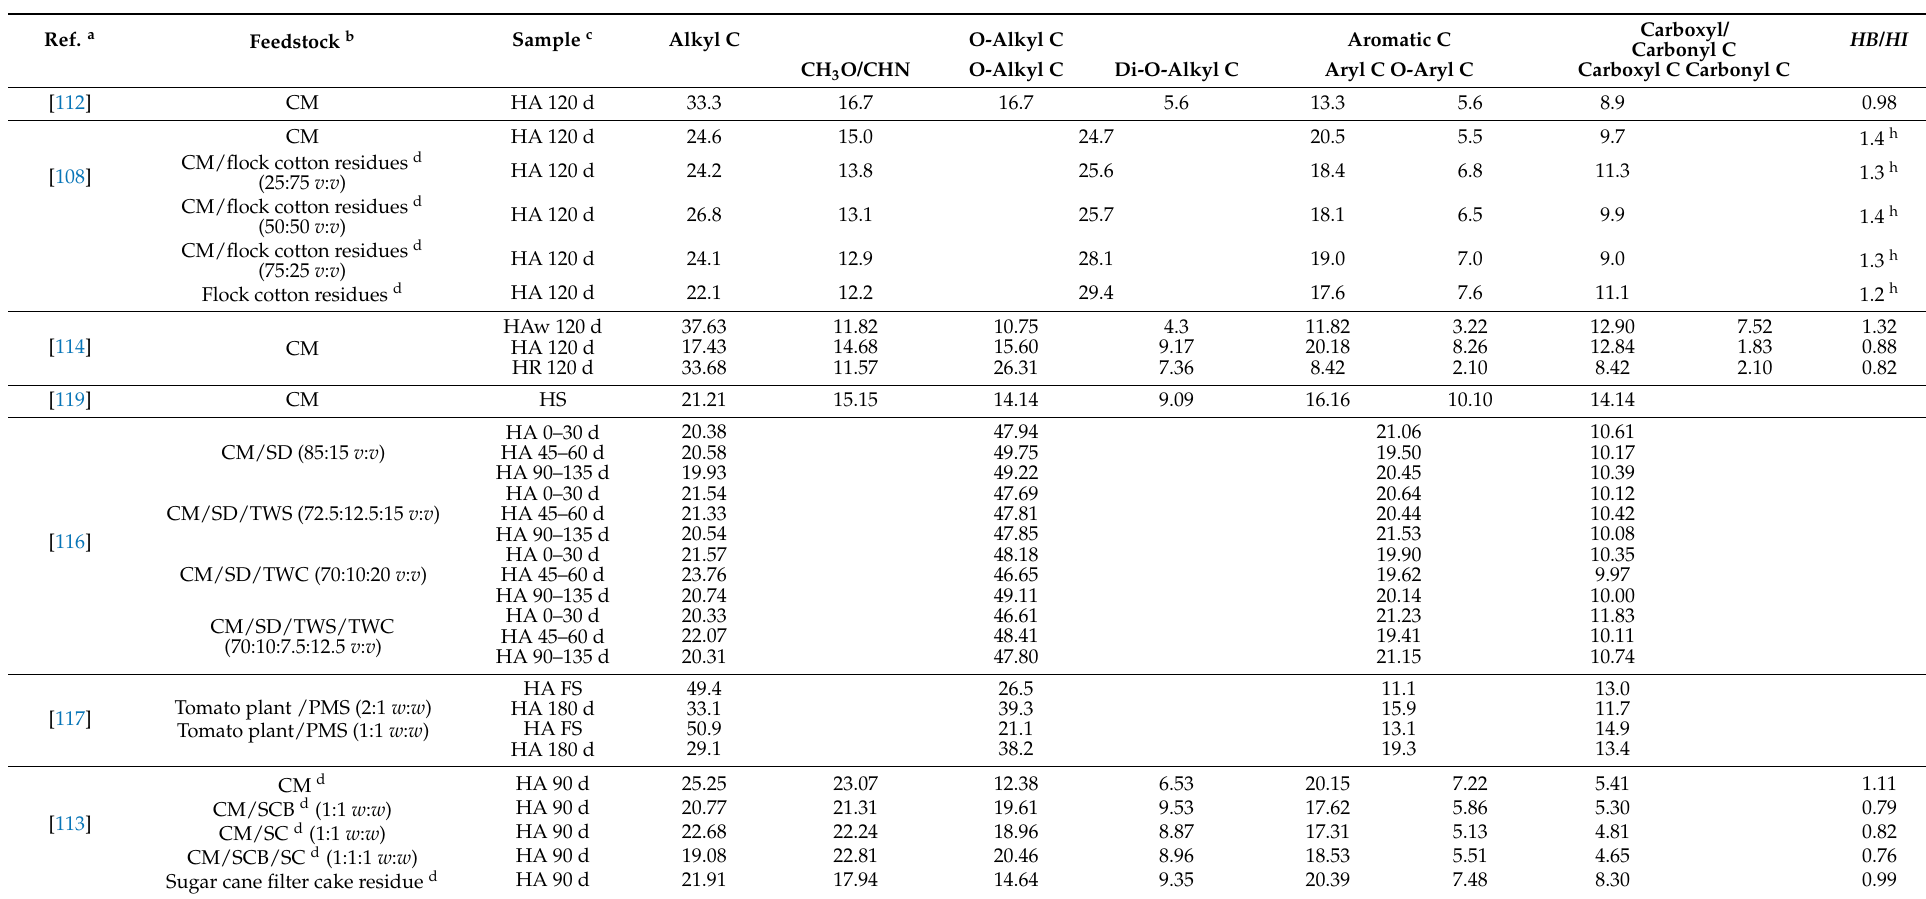
Table 5. Relative areas (% of total area) of the regions of 13 C CP-MAS NMR spectra of extracts of vermicomposts and corresponding feedstocks reported in the literature. The hydrophobic index, HB/HI , is also reported when